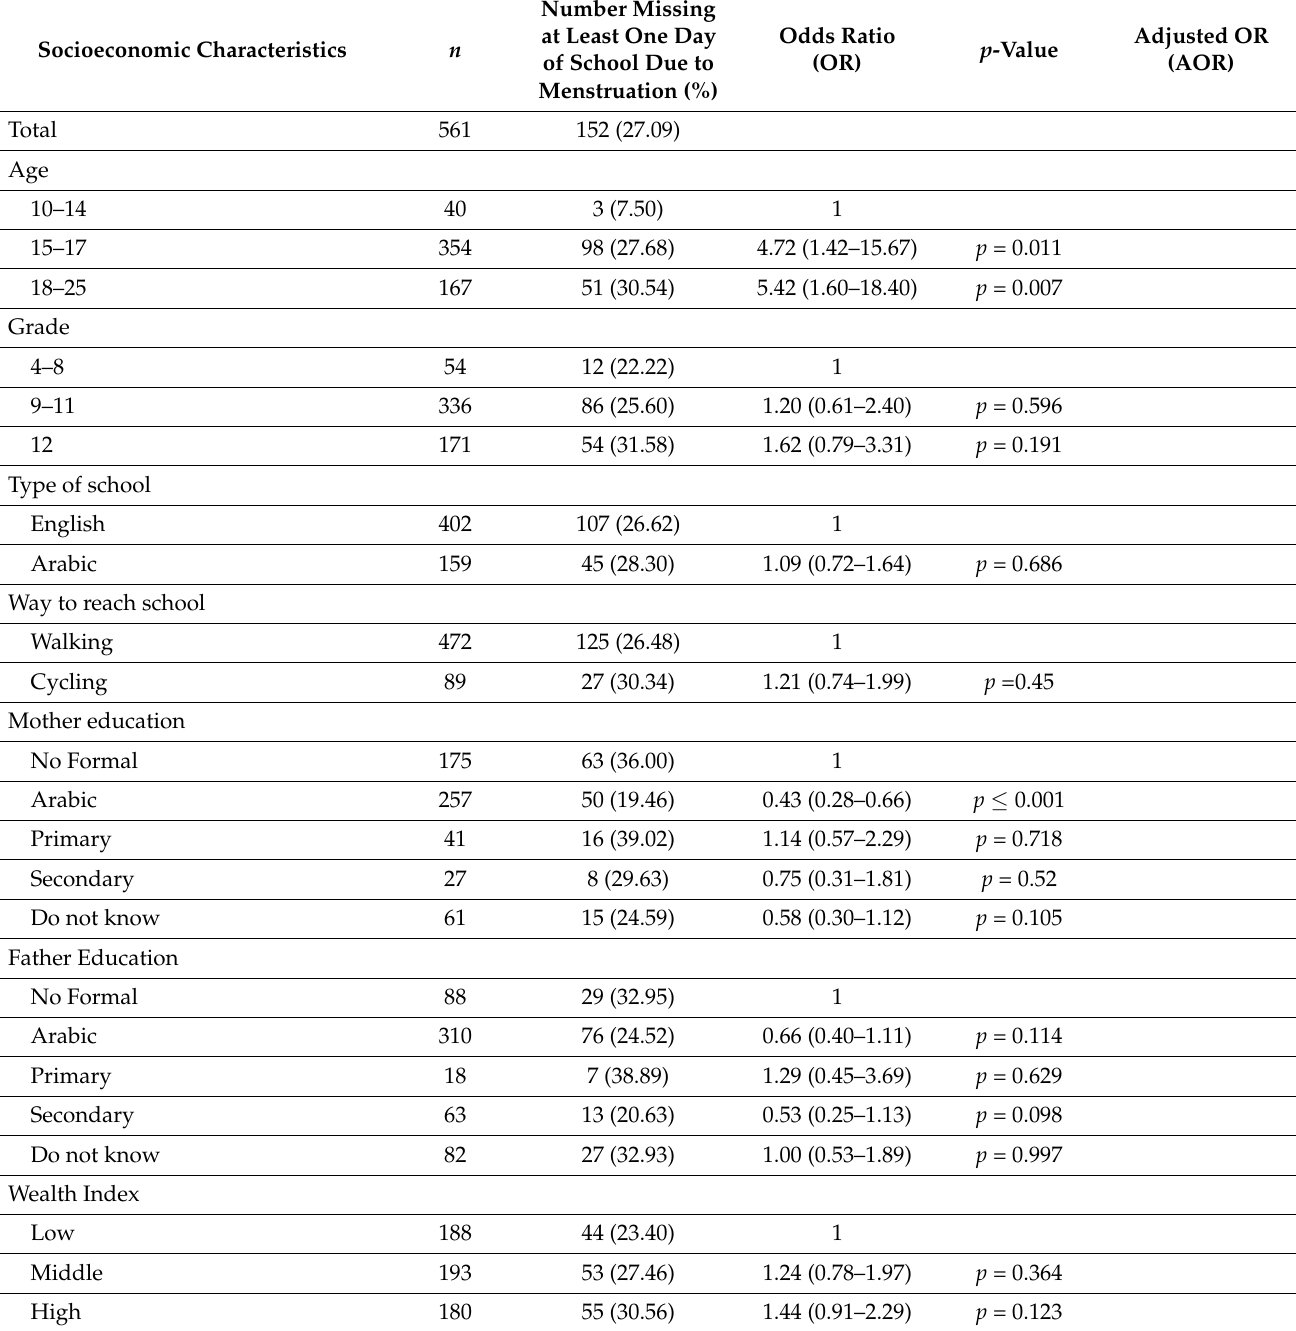
Table 6. Analysis of factors associated with missing at least one day of school due to